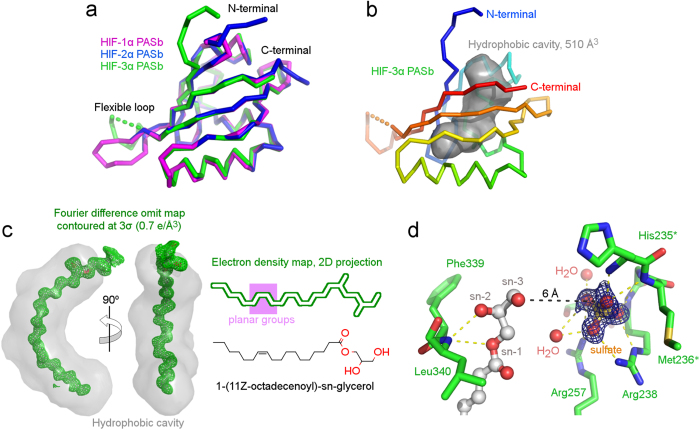
Structure of lipid-bound PASb-3α.(a) High structural identity between the main chain tracing of PASb-3α and the PASb domains of both HIF-1α and HIF-2α (similar core r.m.s.d. of 0.6 Å). (b) However, a 510 Å3 hydrophobic cavity was exclusively identified in the core of PASb-3α (delimited by gray surface), and (c) found to enclose a monoacylglycerol molecule. (d) Extensive network of polar contacts (yellow dashed lines) shared by specific residues in PASb-3α with the lipid and a neighbor sulfate ion, suggesting that minor rearrangements in the protein may allow for binding of phospholipids.